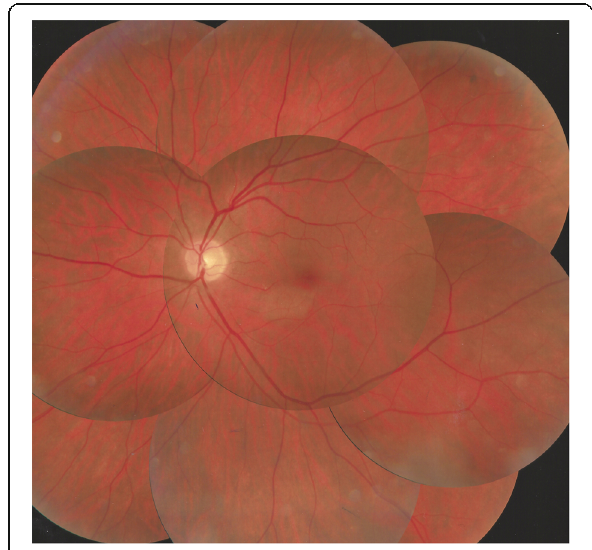
Fig. 14 Fundus picture OS taken 5 weeks after the acute episode showing quasi disappearance of whitish aspect in the infarcted zone (case 1)